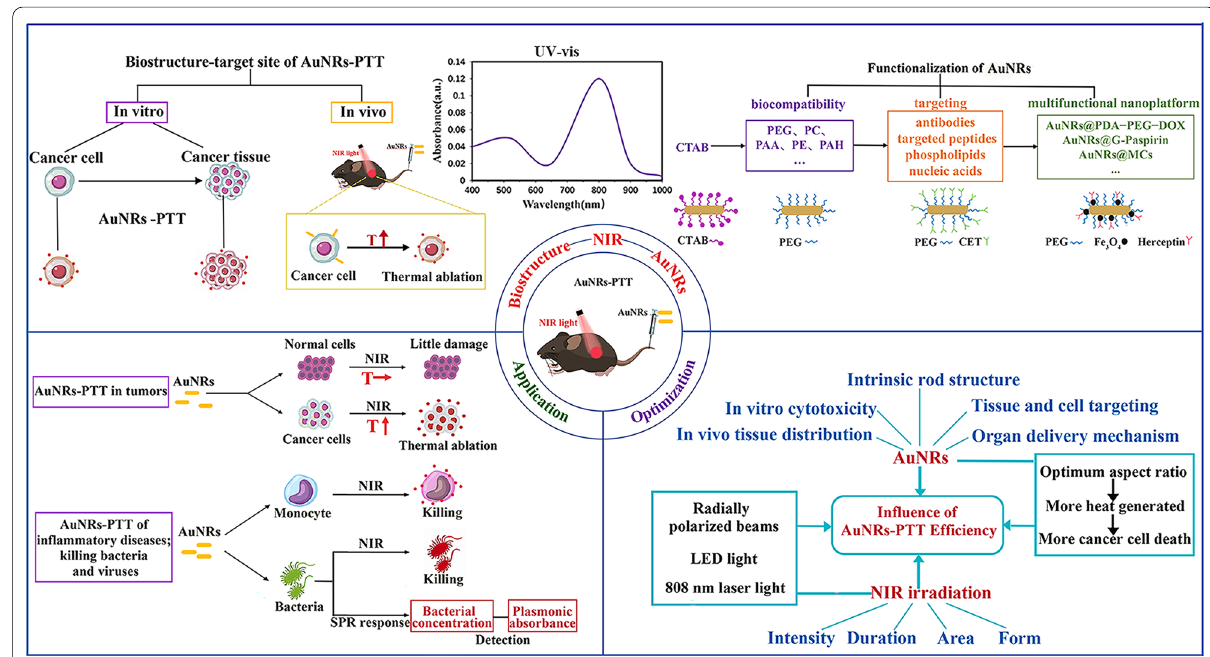
Fig. 1 Gold nanorods-based photothermal therapy: interactions between biostructure, nanomaterial, and near-infrared